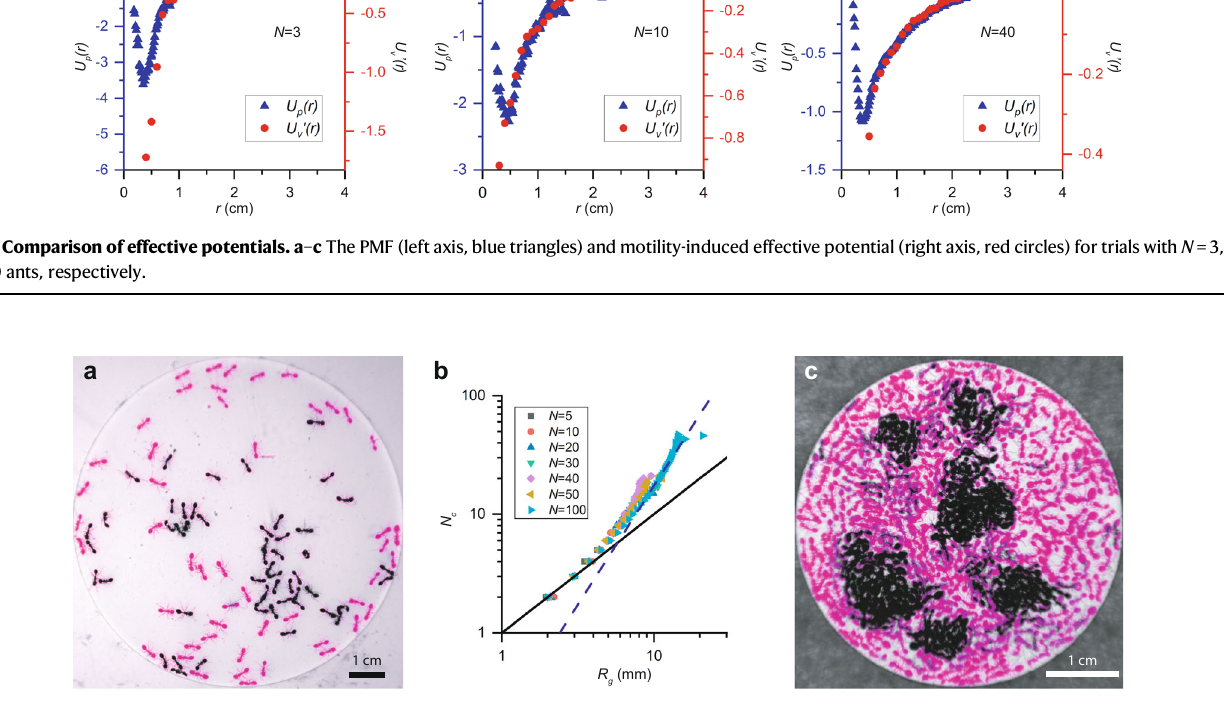
Fig. 3 | Clustering and phase separation. a False color image of 100 ants in a cell with D =9.00cm. Stationary ants are shown in blackand moving ants are shown in magenta. b Number of ants in a cluster versus its radius of gyration for various N . The black line shows N c ∝ R g and the blue dashed line shows N c / R 2 g . c False color